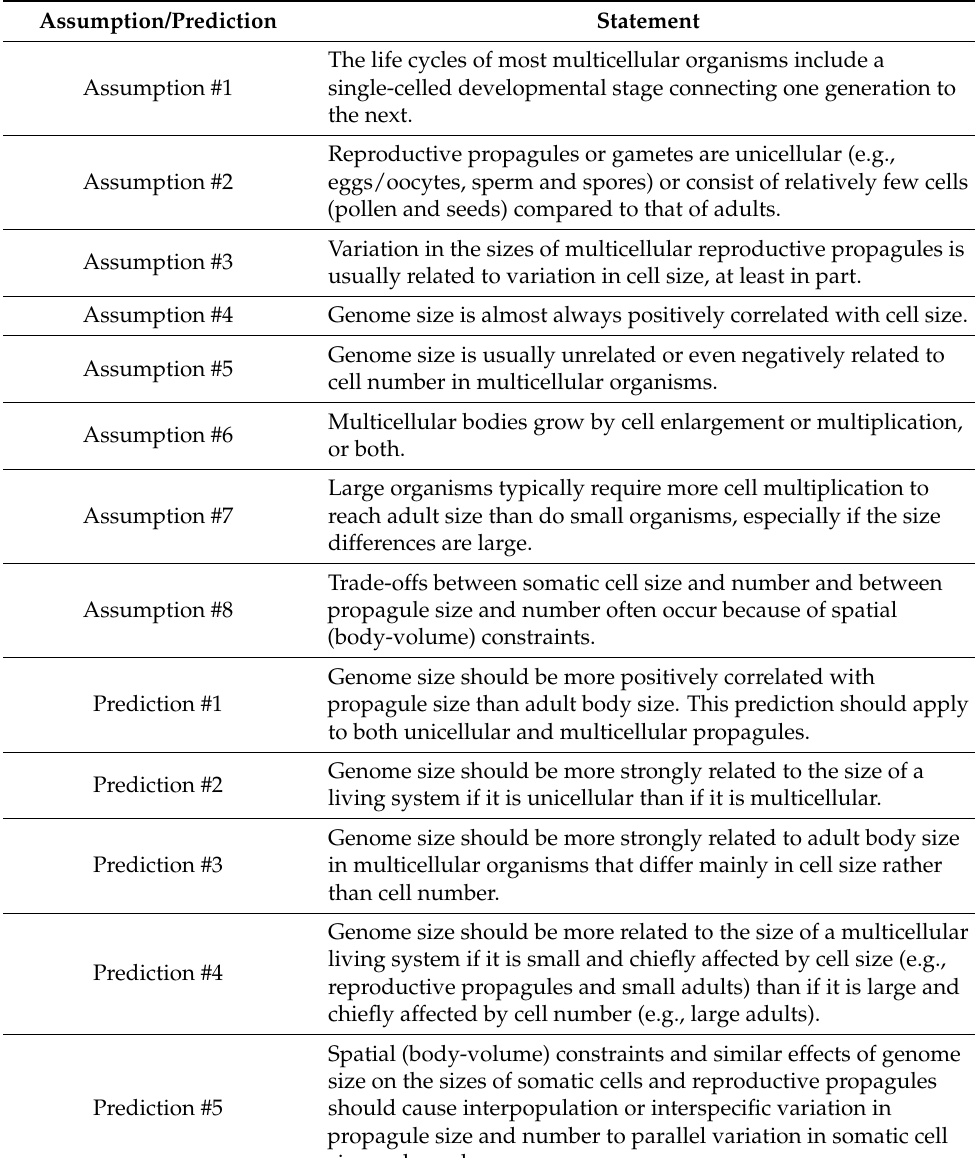
Table 6. The eight assumptions and five predictions of the Single-Cell “Bottleneck’ Hypothe- sis